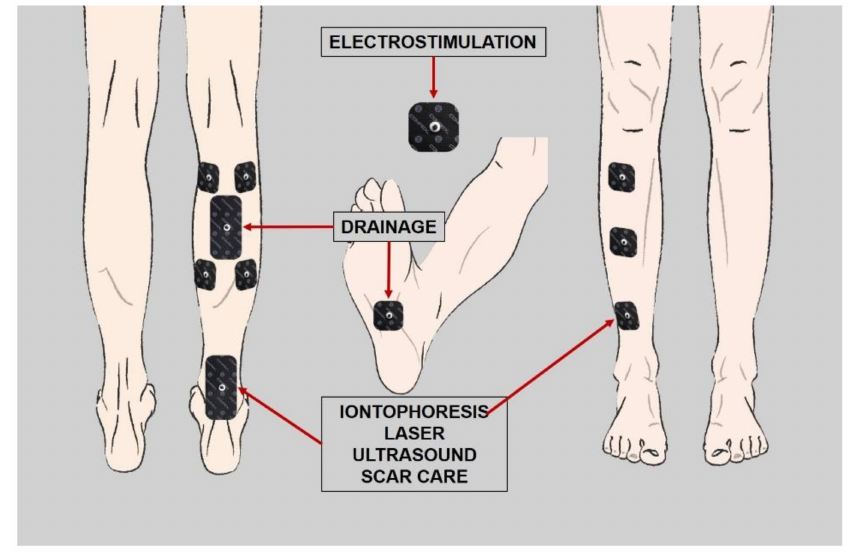
Figure 9. Therapeutic windows to be made in the splint.